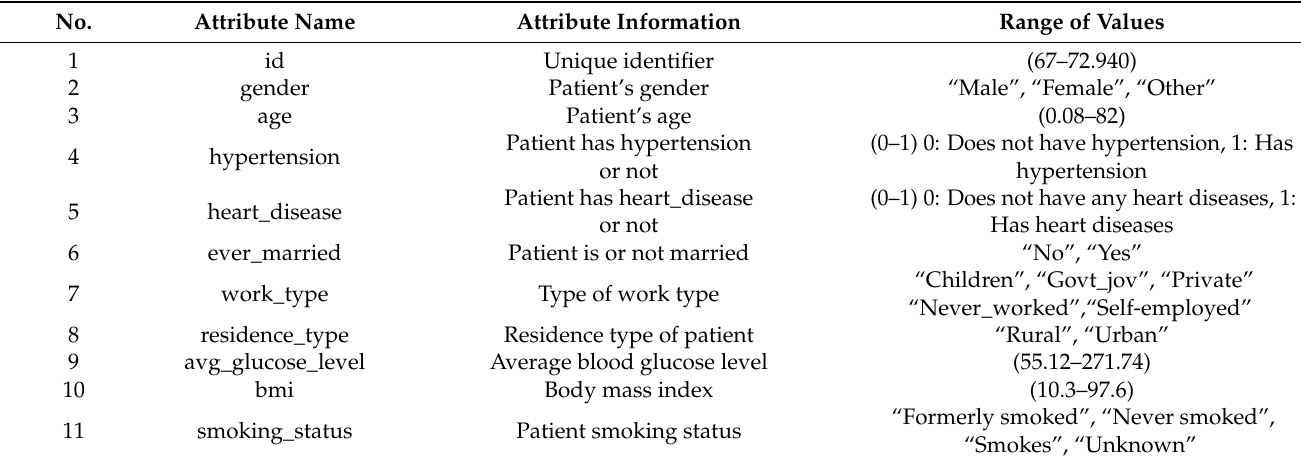
Table 2. Dataset description of